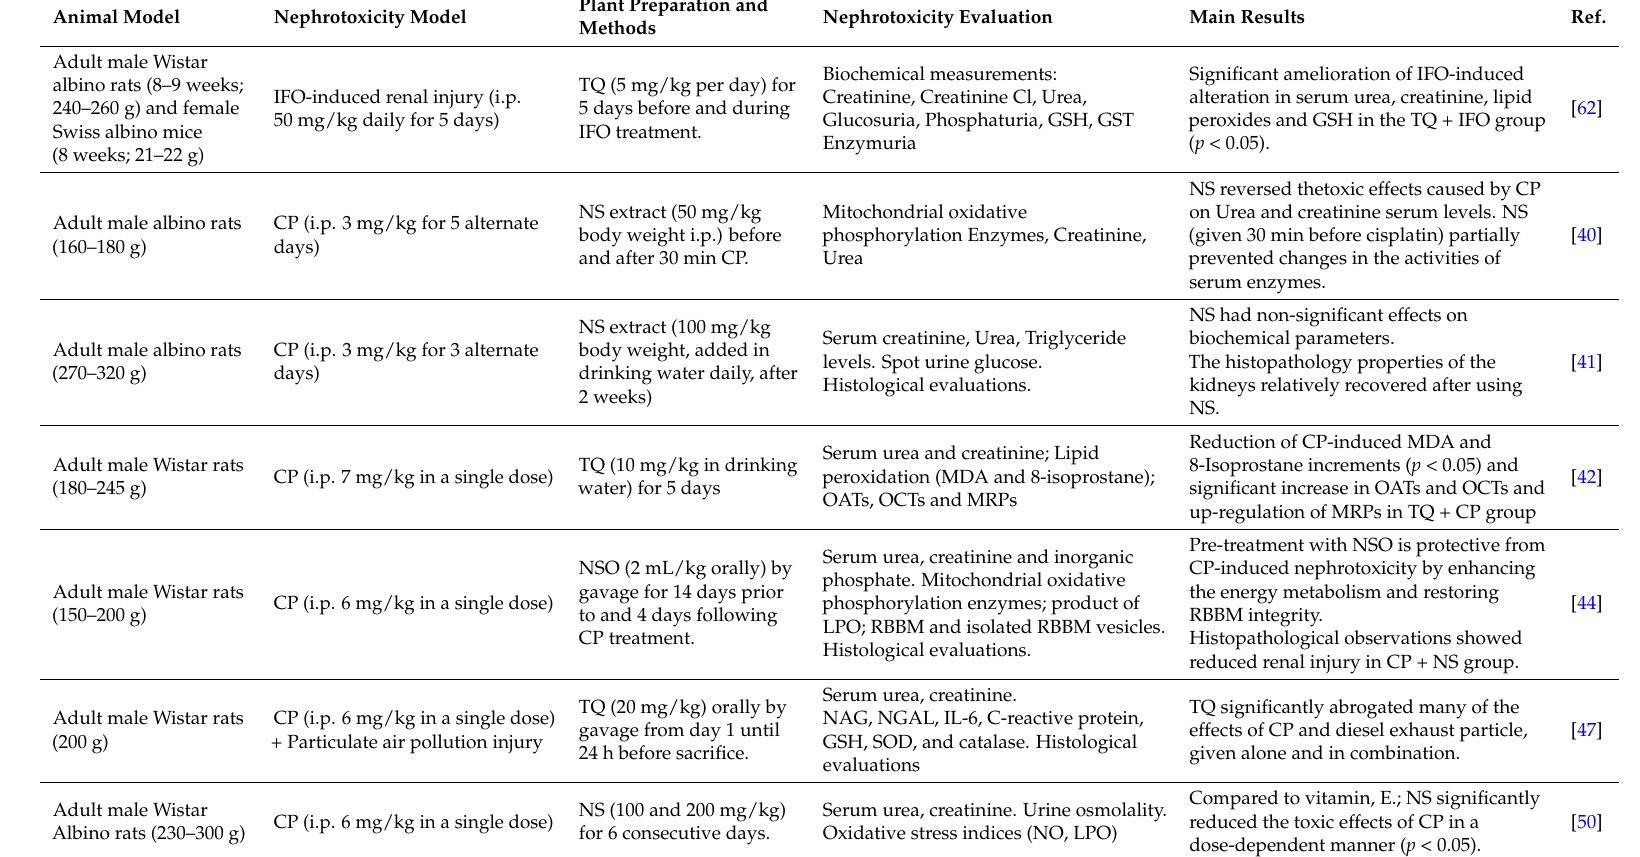
Table 1. Summarized results of the studies included in this